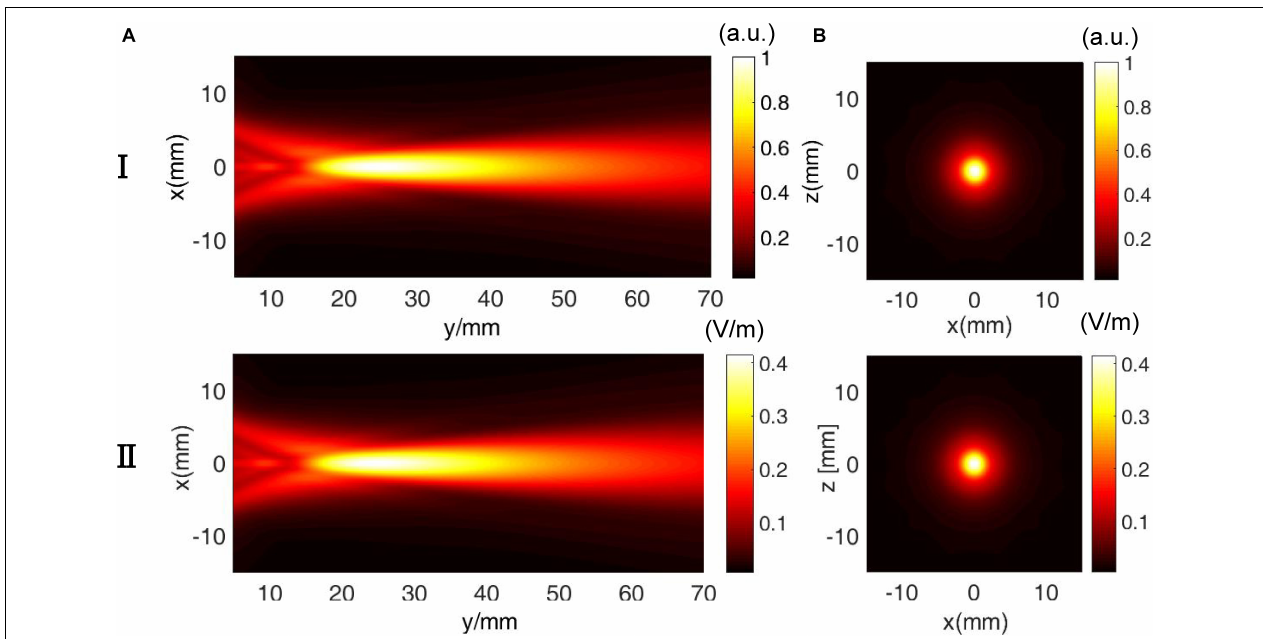
FIGURE 5 | Comparison of the (I) ultrasound pressure field distribution and (II) electrical field intensity distribution at (A) the x – y section ( y = 0 mm) and (B) x – z section ( y = 23 mm) in the simulation.